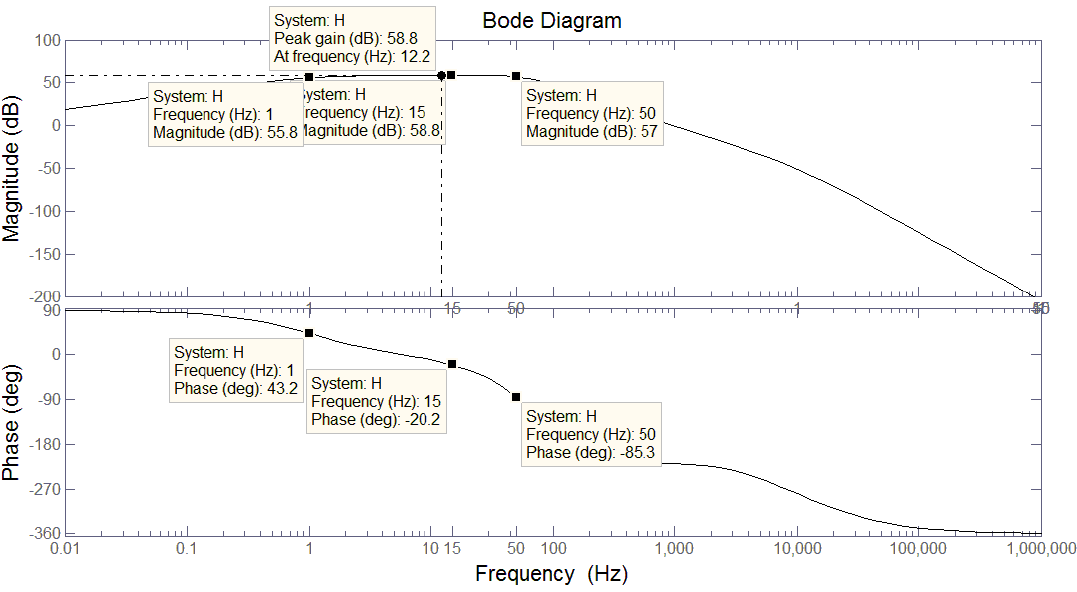
Figure 15. Bode plot of Equation (24).